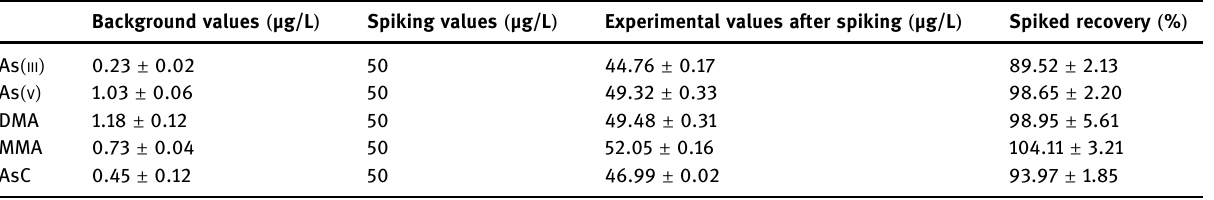
Background values ( μ g/L